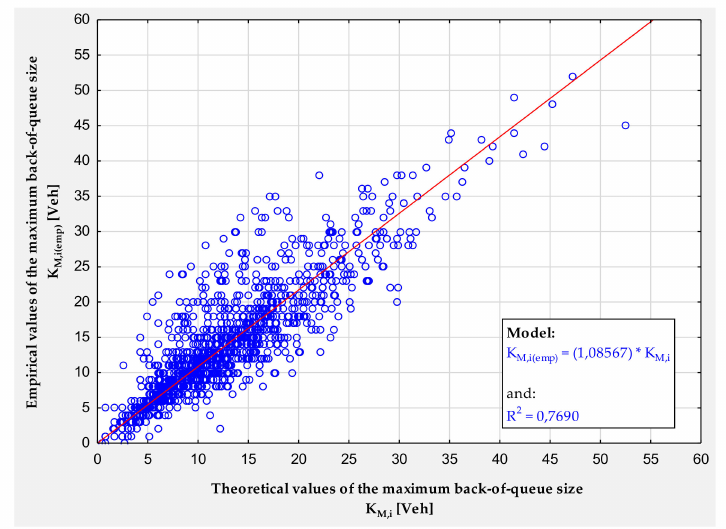
Figure 10. Results of the correlation analysis of the average values of the intensity of starting vehicles from the maximum queue as a function of the average values of the maximum intensity of the service. Figure 11. Results of regression and correlation analysis between empirical values of maximum queue size and theoretical values determined by the proposed model.